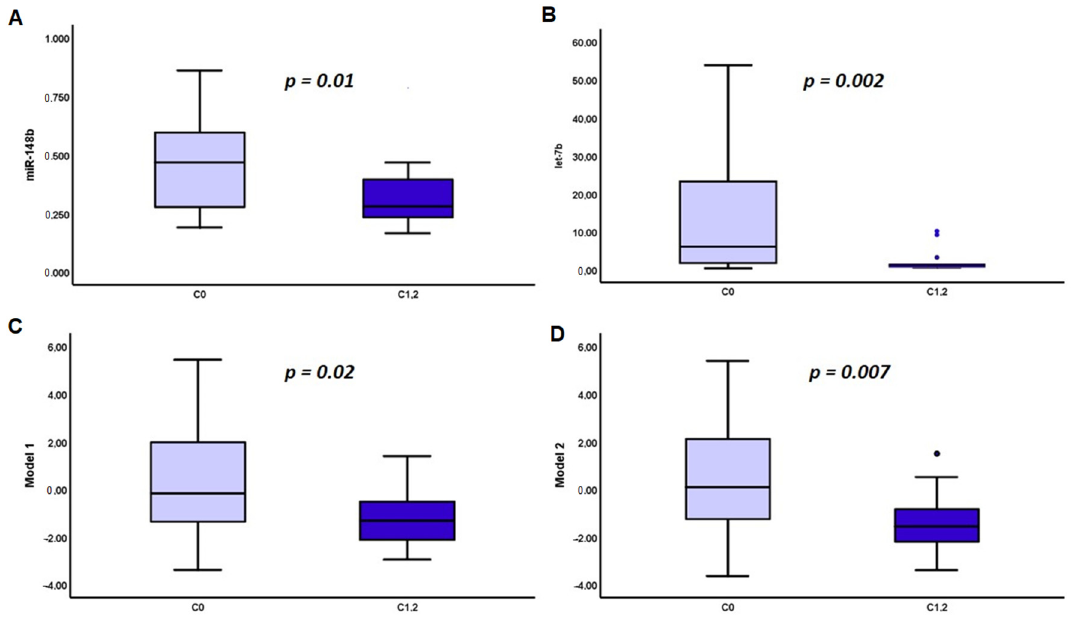
Figure 2. Serum levels of miR-148 ( A ), let-7b ( B ) at time of renal biopsy, Model 1 ( C ), and Model 2 ( D ) in IgAN patients with MEST-C0 and MEST-C1,2.